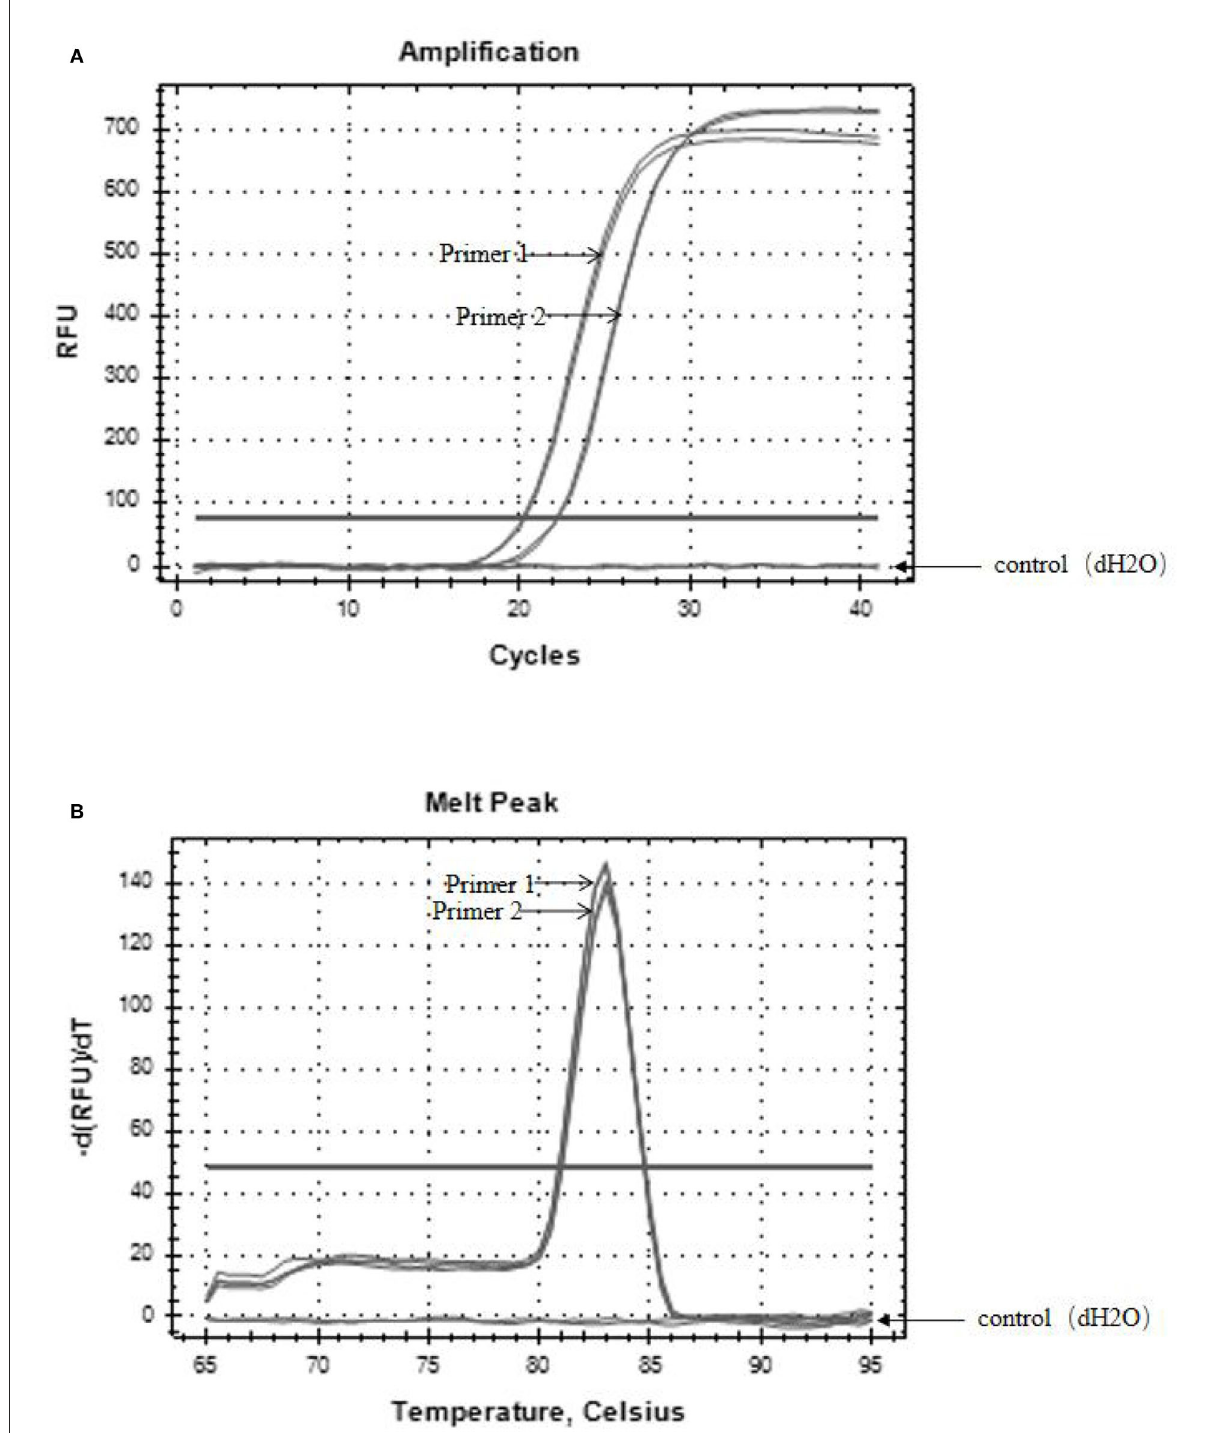
FIGURE3 The results of primer amplified products. (A) Amplification curves of two primer pairs; (B) melting curves of two primer pairs. The control group was dH 2